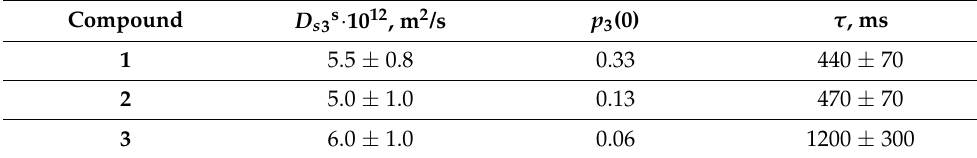
Table 13. The self-diffusion coefficients D s 3s , population p 3 , and lifetimes τ of WSFD molecules in RBCs